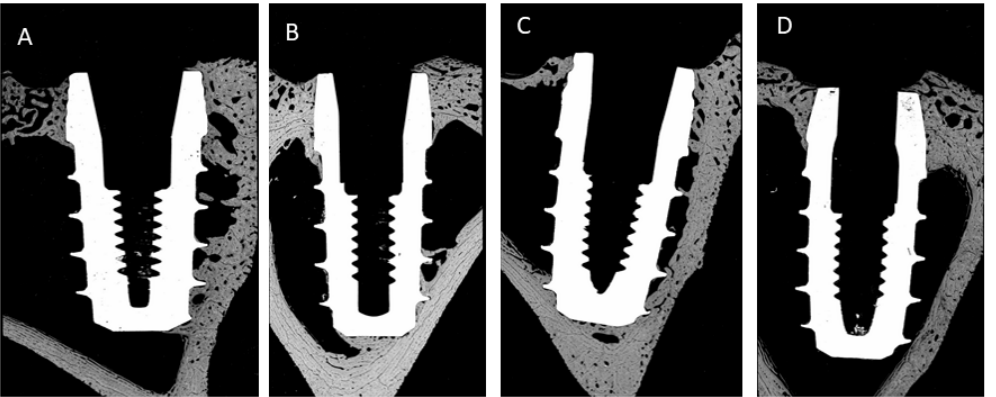
Figure 8. Histologies of the different bone-level dental implants inserted at bone level (h = 0 mm). ( A ) 3 weeks implanted and bone thickness of 1.5 mm; ( B ) 6 weeks implanted and bone thickness of 1.5 mm; ( C ) 3 weeks implanted and bone thickness of 2.5 mm; ( D ) 6 weeks implanted and bone thickness of 2.5 mm.